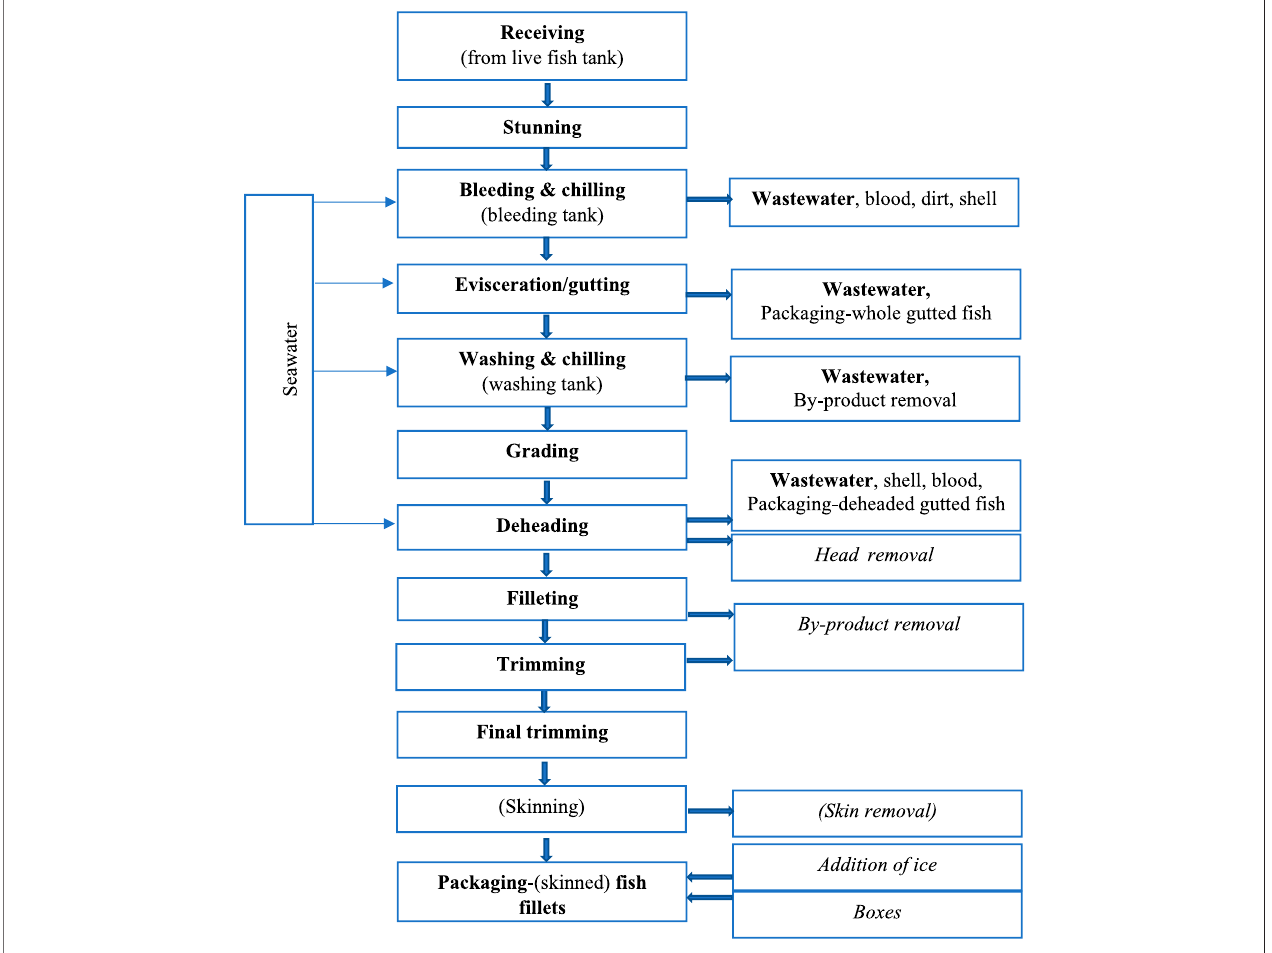
FIGURE 1 | Fish processing pathway schematic [adapted from (Vida ˇ cek and Bugge, 2016)].